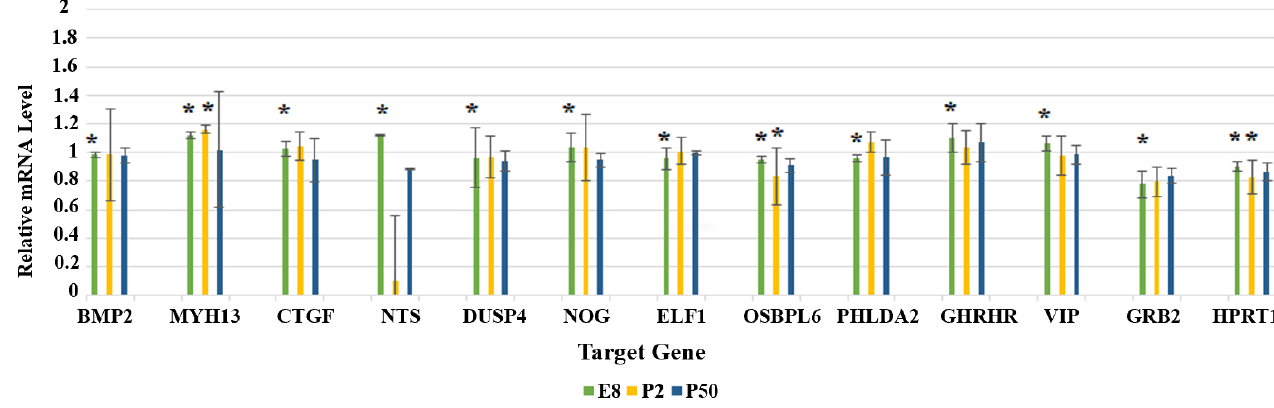
Figure 5. The relative mRNA expression levels of the 13 studied genes in the retina of an eight-day chick embryo (E8), newly hatched chick (P2), and adult chicken (P50) as detected by RT-qPCR. Results are presented as the mean (± SEM) mRNA expression (n = 3 in each group, * p < 0.05).